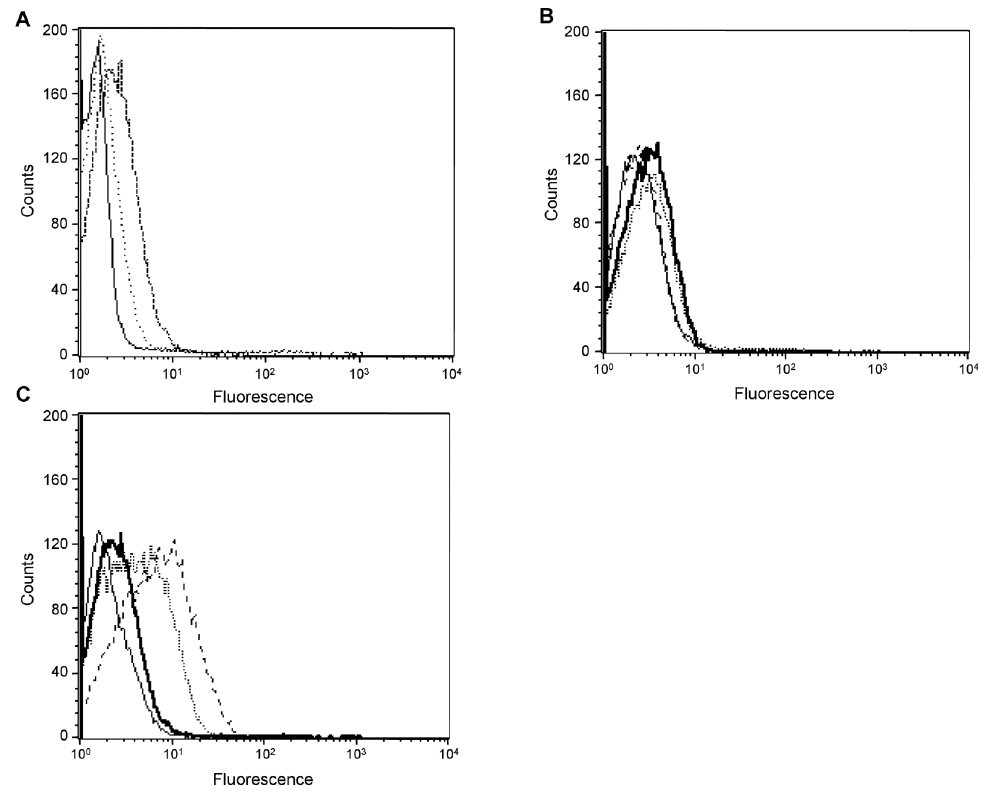
Figure 5. Binding of CCL18 to L1.2 receptor transfectants. A) Untransfected L1.2 cells were incubated with 1 (―), 10 (····) or 100 (- ‒ ) nM Alexa 647-CCL18 and analyzed by flow cytometry. B) Incubation of 100 nM Alexa 647-CCL18 with L1.2/CCR2 (····), CCR4 (- ‒ ) or CCR5 (▬) cells and untransfected L1.2 (―) as negative control. C) A dose-dependent binding of CCL18 to L1.2/ CCR3 transfectants was clearly visible when using 1 (―), 10 (····) or 100 (- ‒ ) nM Alexa 647-CCL18. Untransfected L1.2 stained with 100 nM CCL18 (▬) are shown as control. One representative experiment out of two is shown.